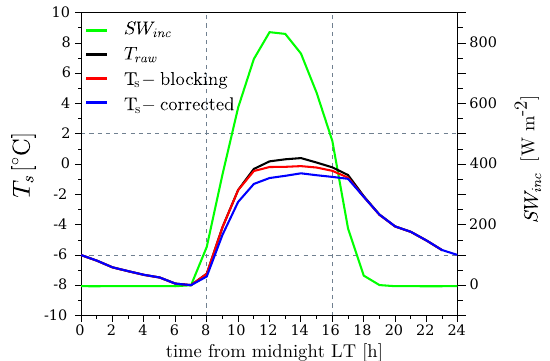
Figure 8. Mean daily cycle calculated for the entire campaign, from midnight to midnight local time (LT), of raw estimates of sur- face temperature (black), surface temperature derived from the “ T s - blocking” method (red), surface temperature derived from the “ T s - corrected” method (blue) and incoming shortwave radiation